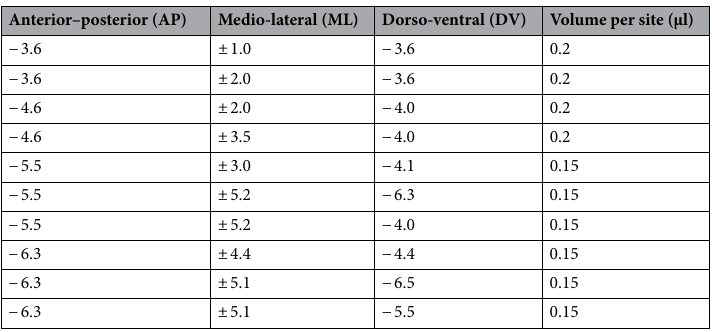
Table 1. Coordinates relative to Bregma (in mm) and corresponding volumes (in µl) for NMDA injections in the